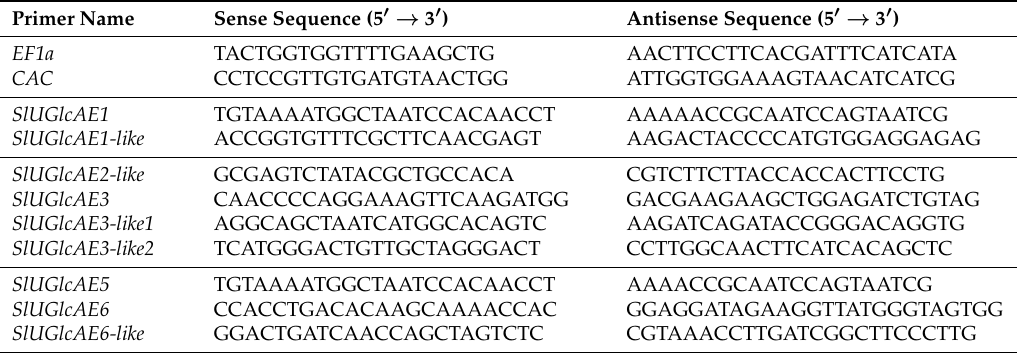
Table 2. Primer sequences used for quantitative real-time PCR in the